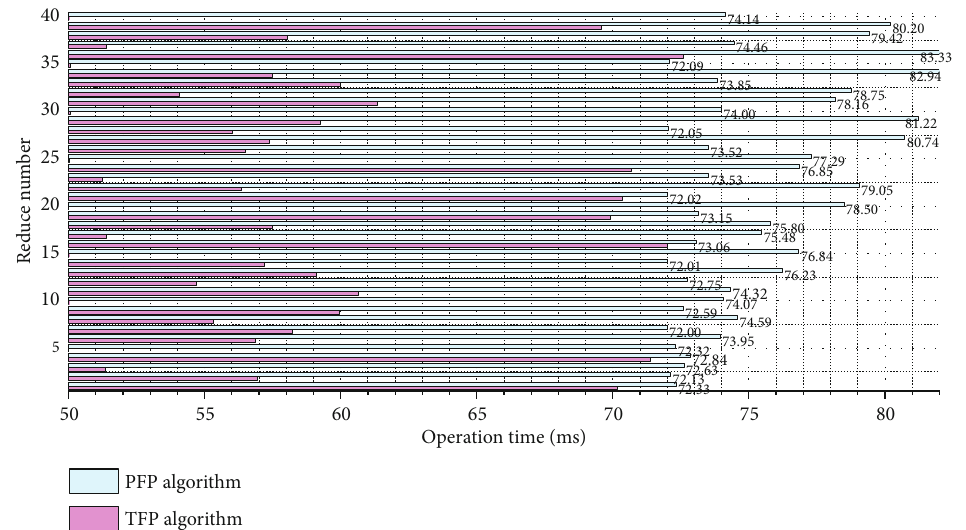
Figure 3: Comparison of algorithm running time under di ff erent numbers of Reduces based on the data set accidents.dat.